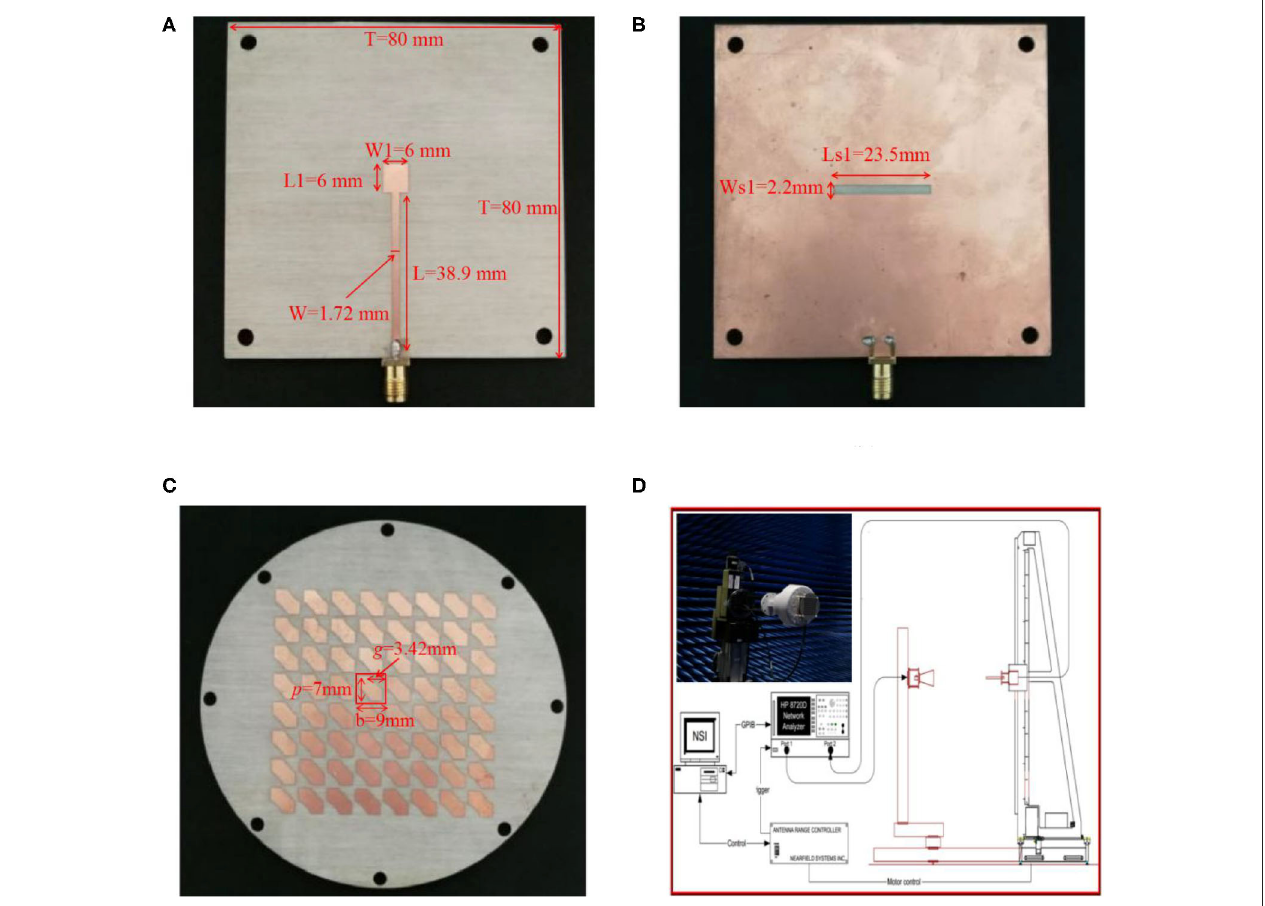
FIGURE 6 | Photograph of the designed antenna and Antenna test system. (A) feeder line of slot antenna. (B) surface of slot antenna. (C) surface of MS. (D) antenna measurement setup.